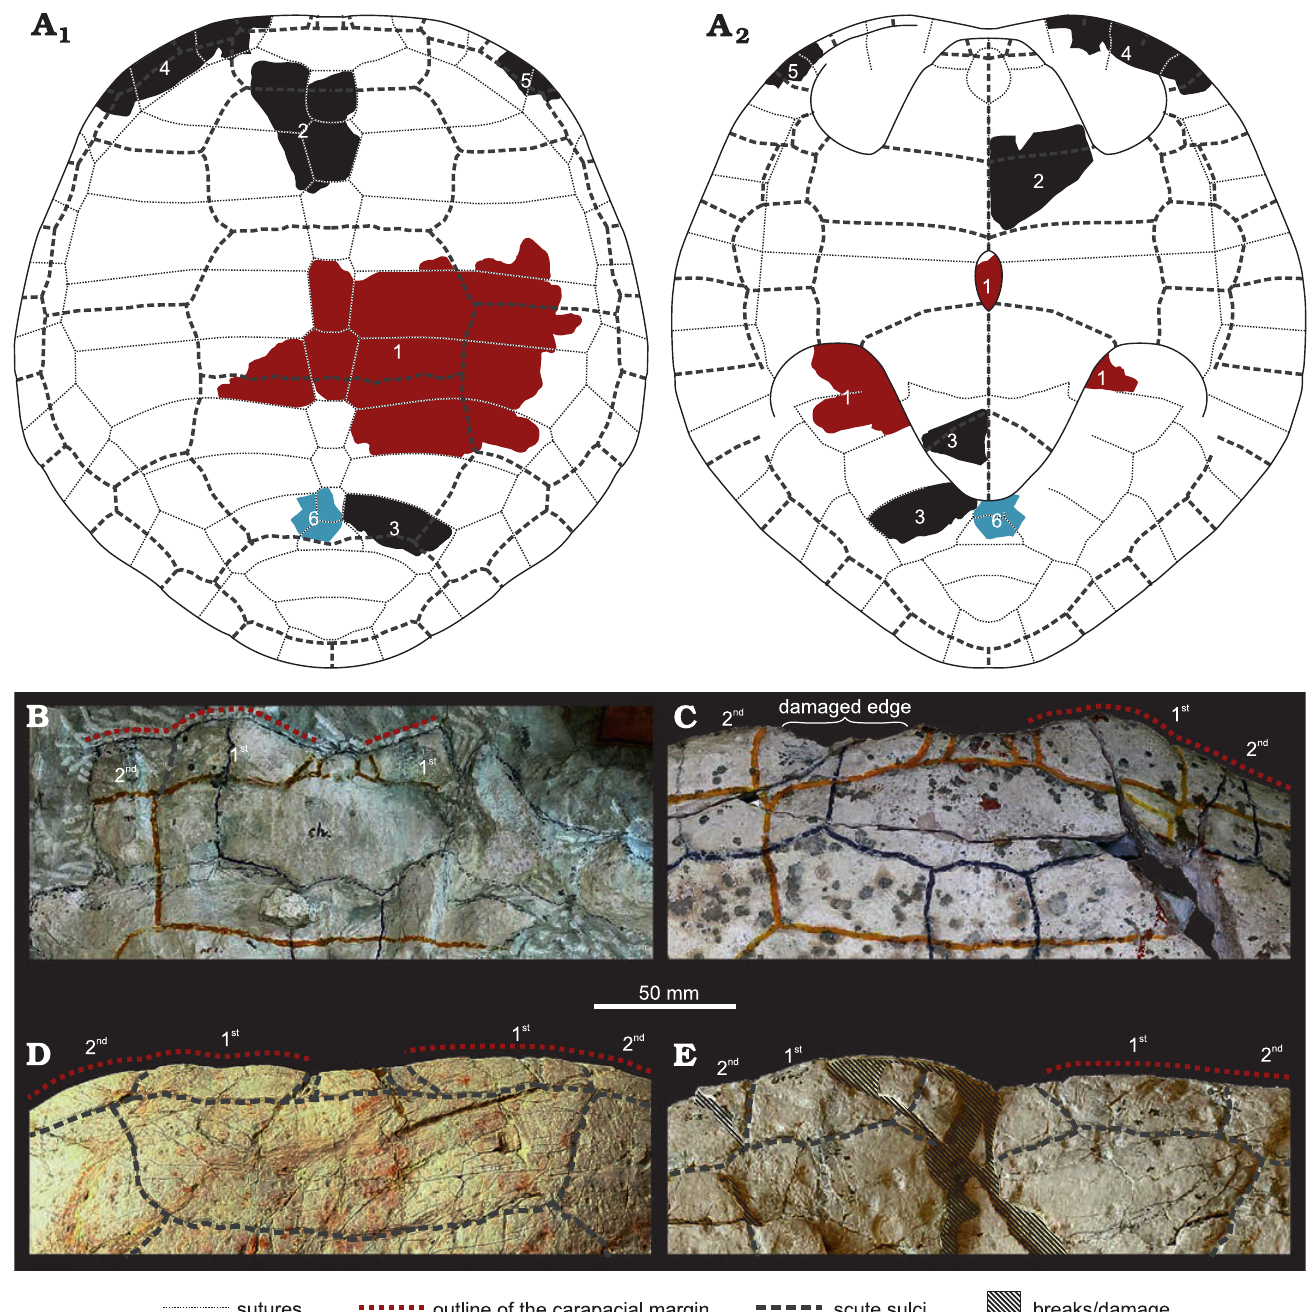
Fig. 6. A . Approximate position of the identifiable fragments of the thalassochelydian turtle Craspedochelys ? sp., MZ VIII Vr-71, within the shell, in dorsal (A 1 ) and ventral (A 2 ) views (schematic reconstruction of Craspedochelys spp. based on Anquetin et al. 2014, 2017, and TS personal observations, modified to fit the observed morphologies). Numbers represent the elements illustrated in the text: 1, Fig. 2; 2, Fig. 3A; 3, Fig. 3B; 4, Fig. 4A; 5, Fig. 4B; 6, Fig. 4D. Fragments likely belonging to the same individual are indicated by the same colour. B – E . Anterior edges of the carapace of Plesiochelys etalloni (Pictet and Humbert, 1857), NMS 8514/NMS 118 ( B ) and NMS 8727/NMS 116 ( C ), Craspedochelys jaccardi (Pictet, 1860), NMS 101 ( D ), and Craspedochelys picteti (Rütimeyer, 1873), NMS 9149/NMS 608 ( E ); all from the Kimmeridgian of Solothurn, Switzerland. The numbers indicate marginal scutes. Note the anteriorly protruding first marginal of Plesiochelys etalloni (B, C) and straight anterior edge in Craspedochelys spp. (D,